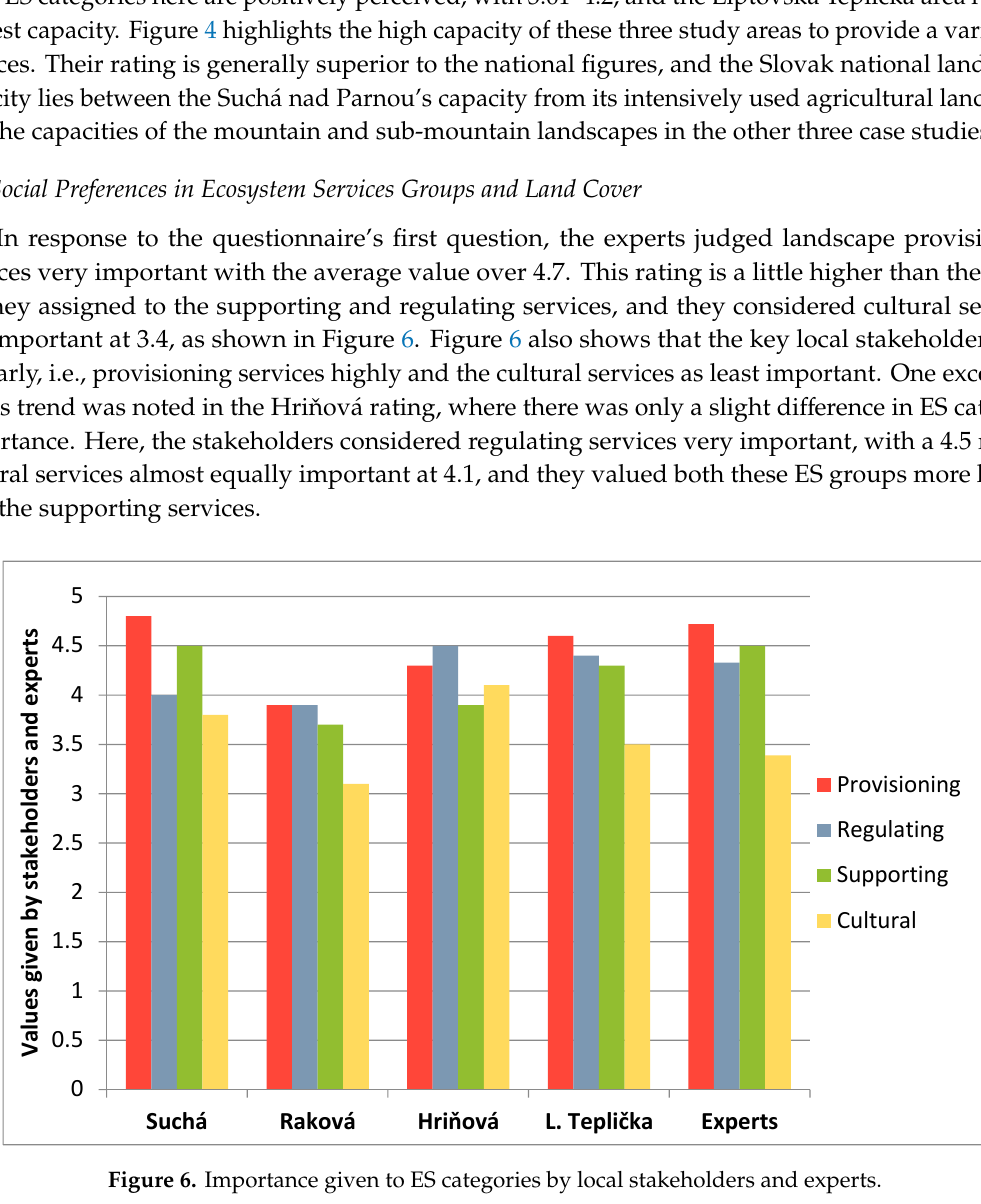
Figure 6. Importance given to ES categories by local stakeholders and experts.